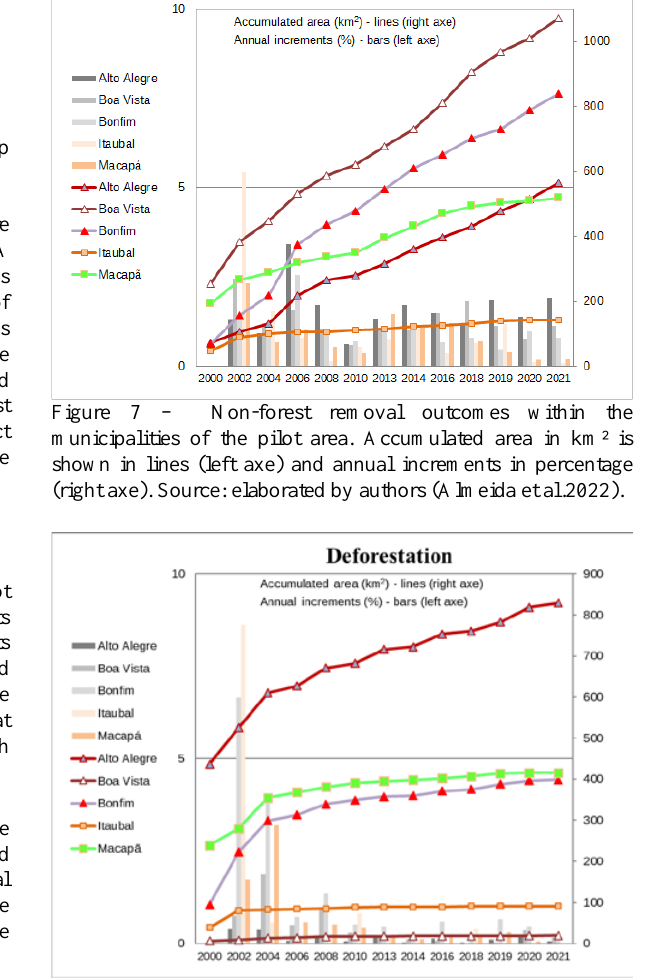
Figure 8 – Deforestation outcomes within the municipalities of the pilot area. Accumulated area in km² is shown in lines (left axe) and annual increments in percentage (right